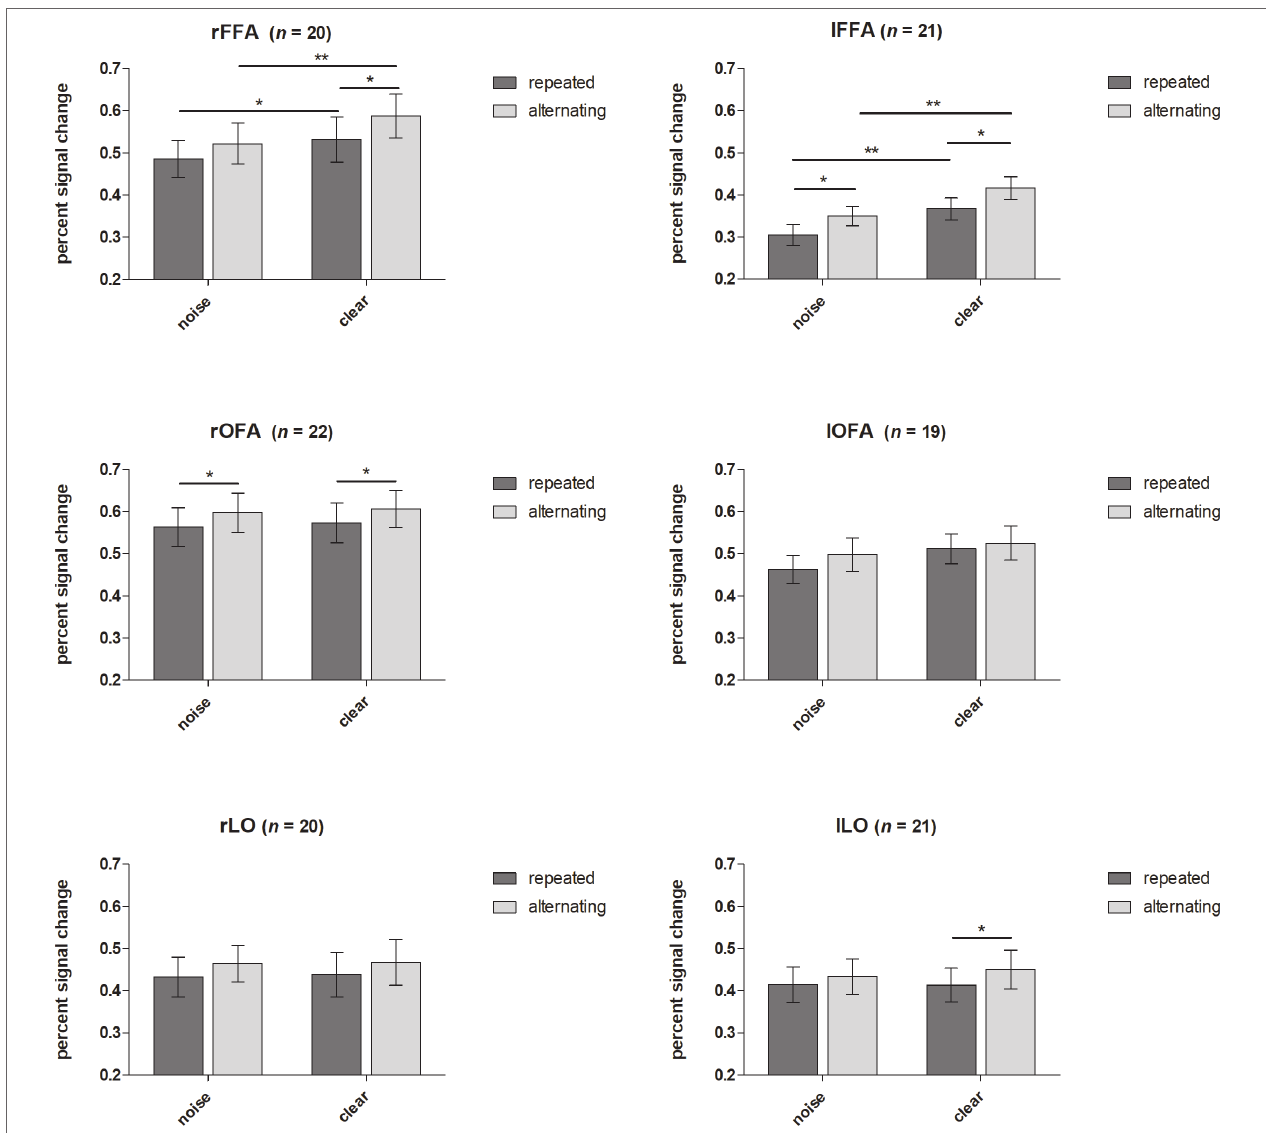
FIGURE 4 | Effects of noise and repetitions. Percent signal changes of FFA, OFA, and LO (left and right hemispheres for each) are presented for condition and trial type. Error bars indicate standard errors. Displayed significant differences refer to Fisher’s LSD post hoc test. * p < 0.05, ** p <